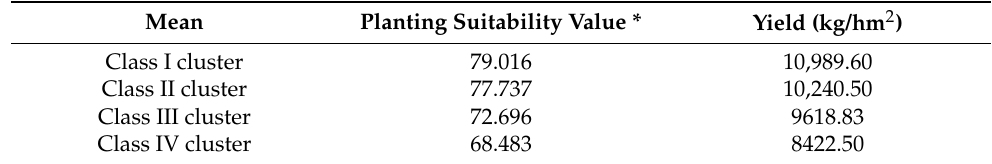
Table 3. Group analysis